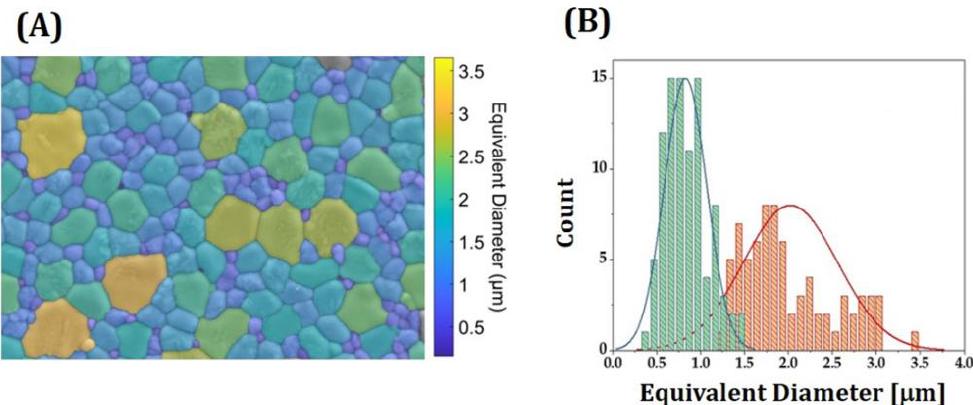
Figure 12. ( A ) Representative colored image reconstructed from a FE-SEM image showing grains with different colors and ( B ) counts as a function of equivalent diameter. The pink and green colors in Figure 12(B) represent size distributions of large and small grains, respectively.